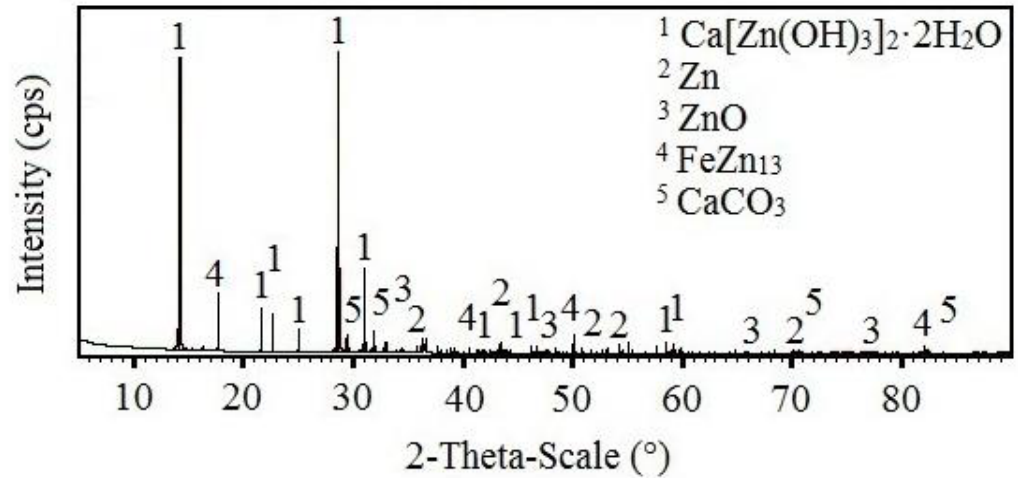
Figure 26. XRD analysis of HDG sample exposed for the duration of 3 months in simulated concrete pore solution of pH 12.8 without addition of MnO 4 − .